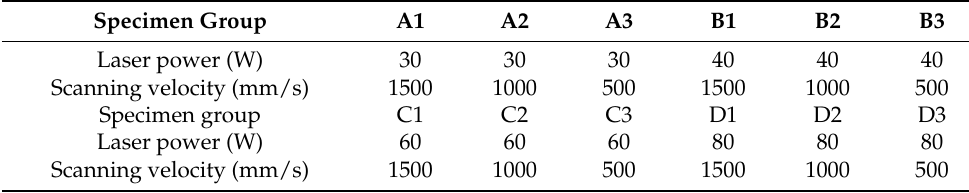
Table 2. The overview of the process parameters for the different specimens.